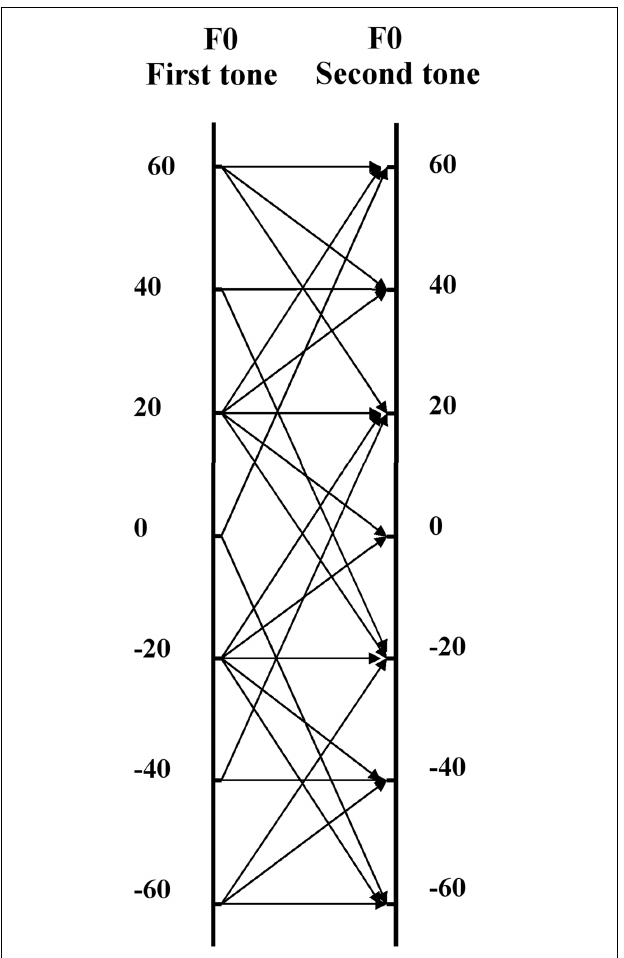
FIGURE 2 | The schema of 22 F0 combinations (see thin lines with arrows) which were used for creating the tone-pairs with 0 cents, plus and minus 20 cents, 40 cents, and 60 cents F0 difference. The two vertical lines correspond to the F0 scale of the first and second stimulus. The numbers at these lines show the relative F0 distance of the corresponding stimulus from the center of the pitch region (in cents).